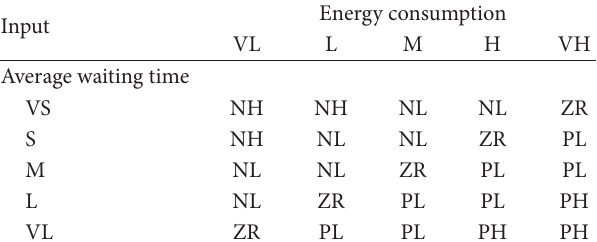
Table 1: Rule base of fuzzy logic